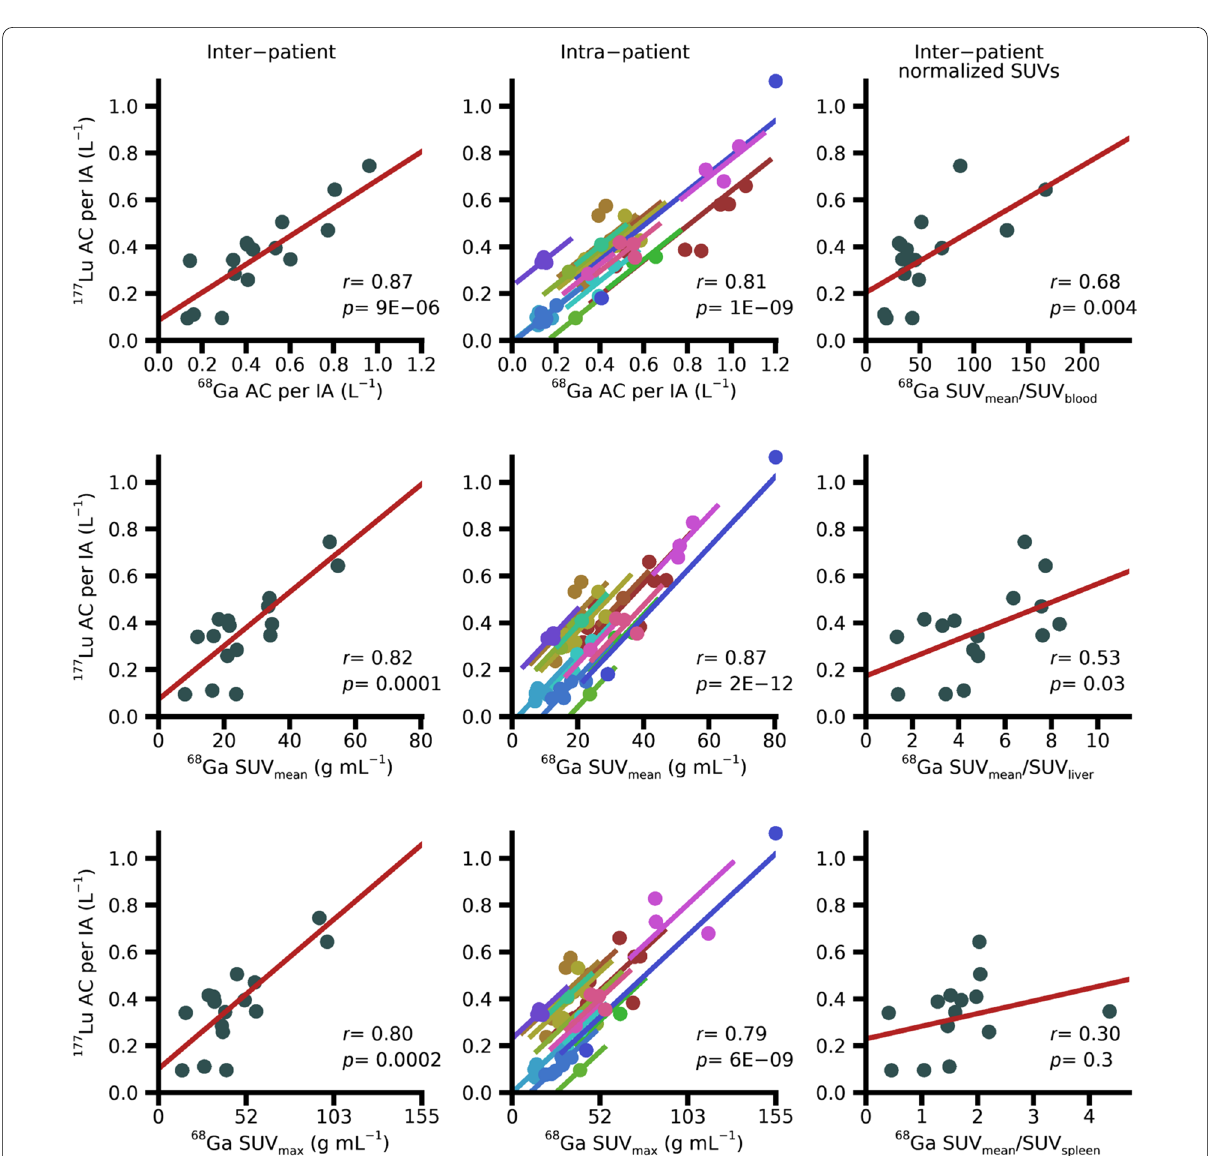
columns) and intra-patient (middle column) analyses of the 177 Lu activity concentration per injected activity are shown as a function of 68 Ga activity concentration per injected activity, 68 Ga-SUV mean , 68 Ga-SUV max , and various 68 Ga-SUV ratios. For the intra-patient analyses, different colours represent different